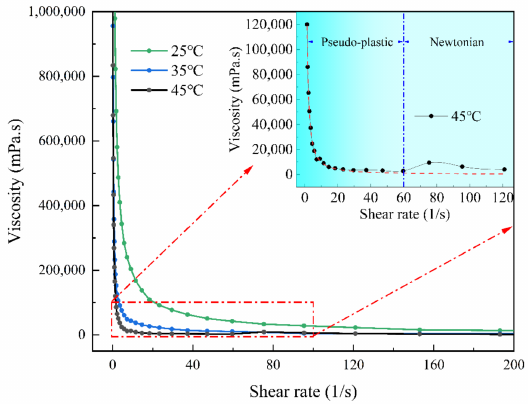
Figure 1. Effect of shear rate and temperature on viscosity